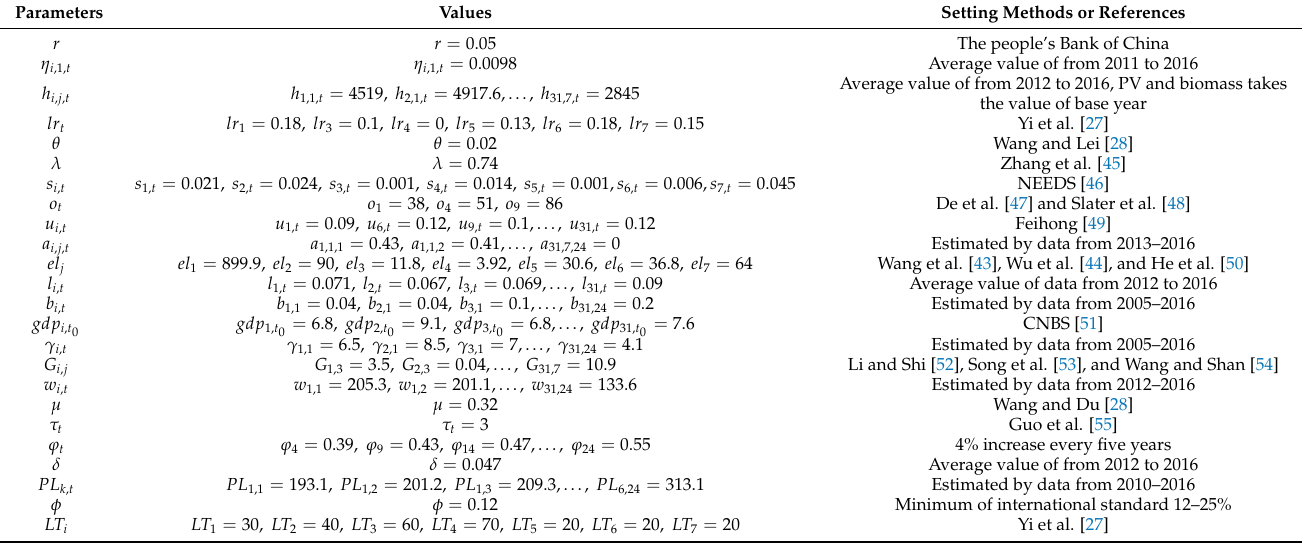
Table 1. Values and setting methods of model parameters.